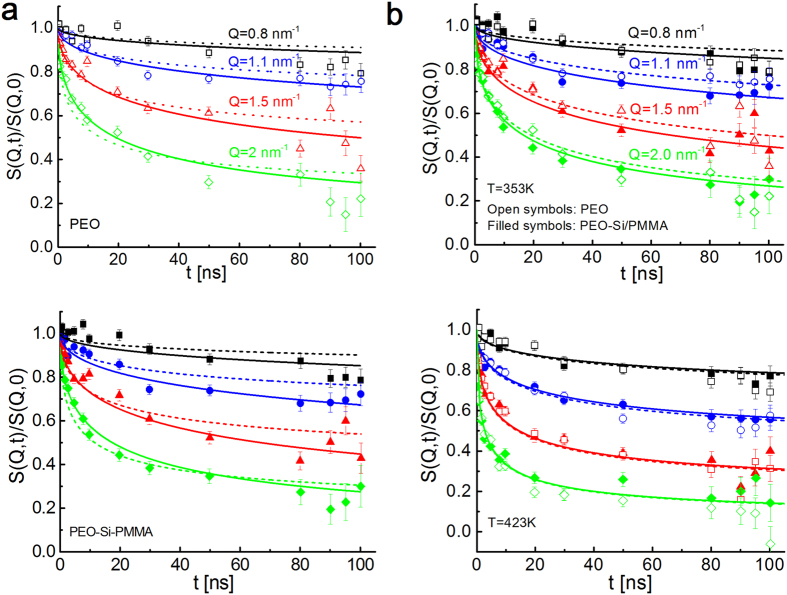
Neutron spin-echo and fitting results.(a) PEO and PEO-SiO2/PMMA composite at 353 K. Dashed and solid curves are global fittings to de-Gennes reptation model using Rouse rates (Wl4) obtained from backscattering and effective rates determined from NSE. (b) Comparison of the NSE data and corresponding reptation model fits of particle-free PEO and PEO in composite with PMMA-coated particles at T < Tg,PMMA and T > Tg,PMMA.